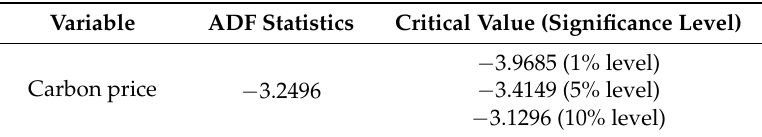
Table 2. The stability test of carbon price sequence of SZA2013.